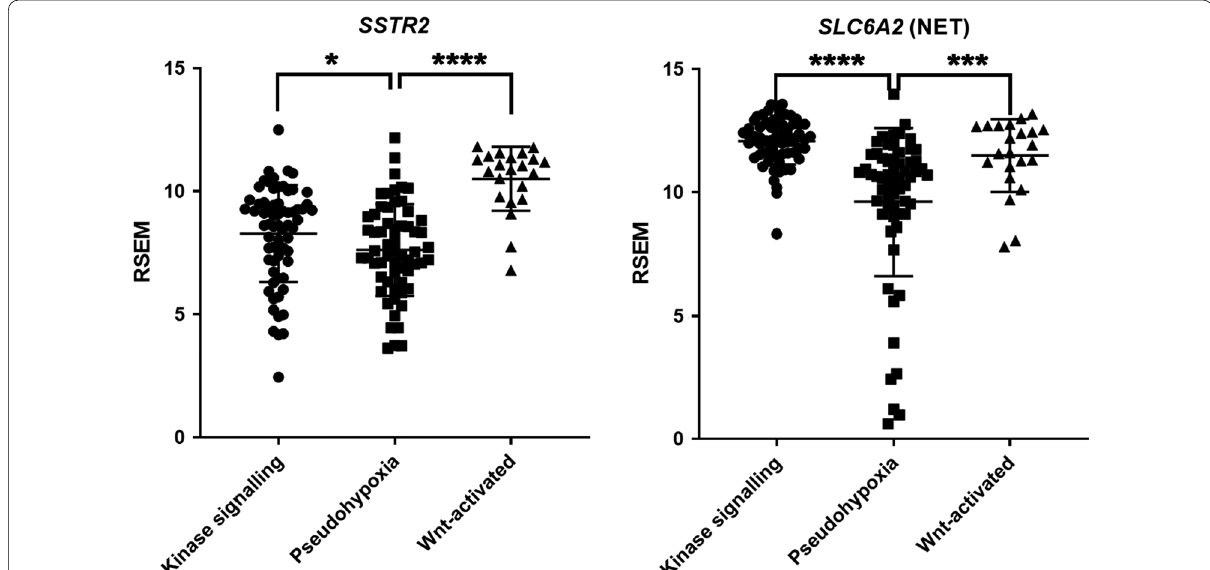
Fig. 3 Expression of Somatostatin and NET transporter in TCGA database. Expression levels of the SSTR2 and SLC6A2 (encoding for NET) in the PPGL TCGA dataset RSEM-normalized, exported via www. cbiop ortal. org (patient stratification into clusters according to Fishbein et al. [6]. Low level of SSTR2 expression in some patients belonging to the pseudohypoxia